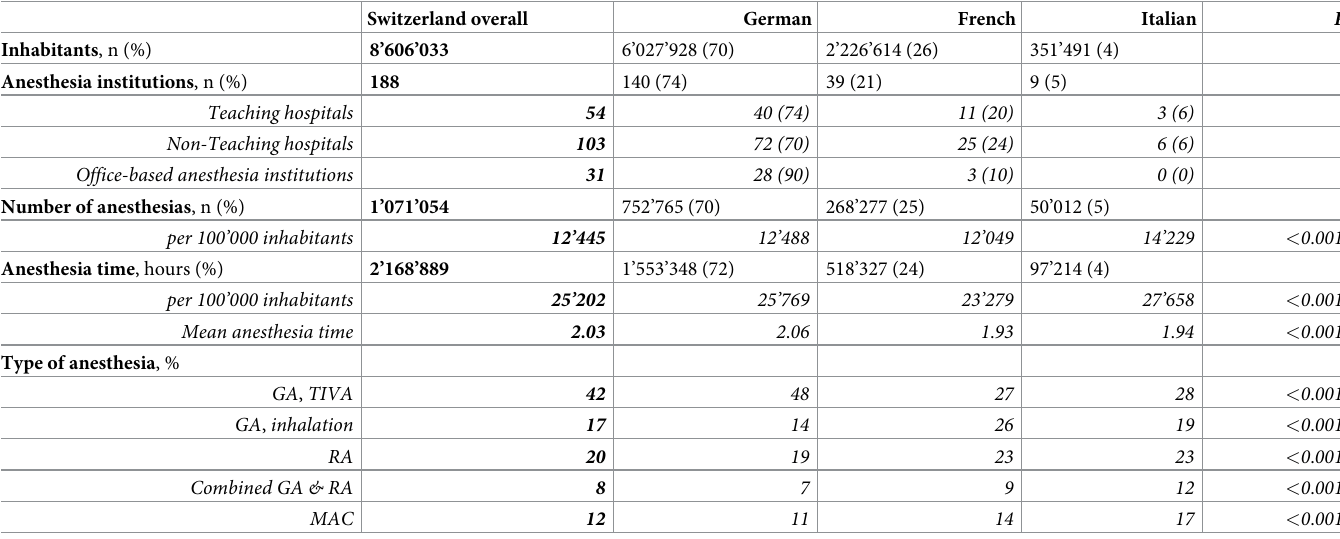
Table 1. Anesthesia institutions and services in Switzerland in